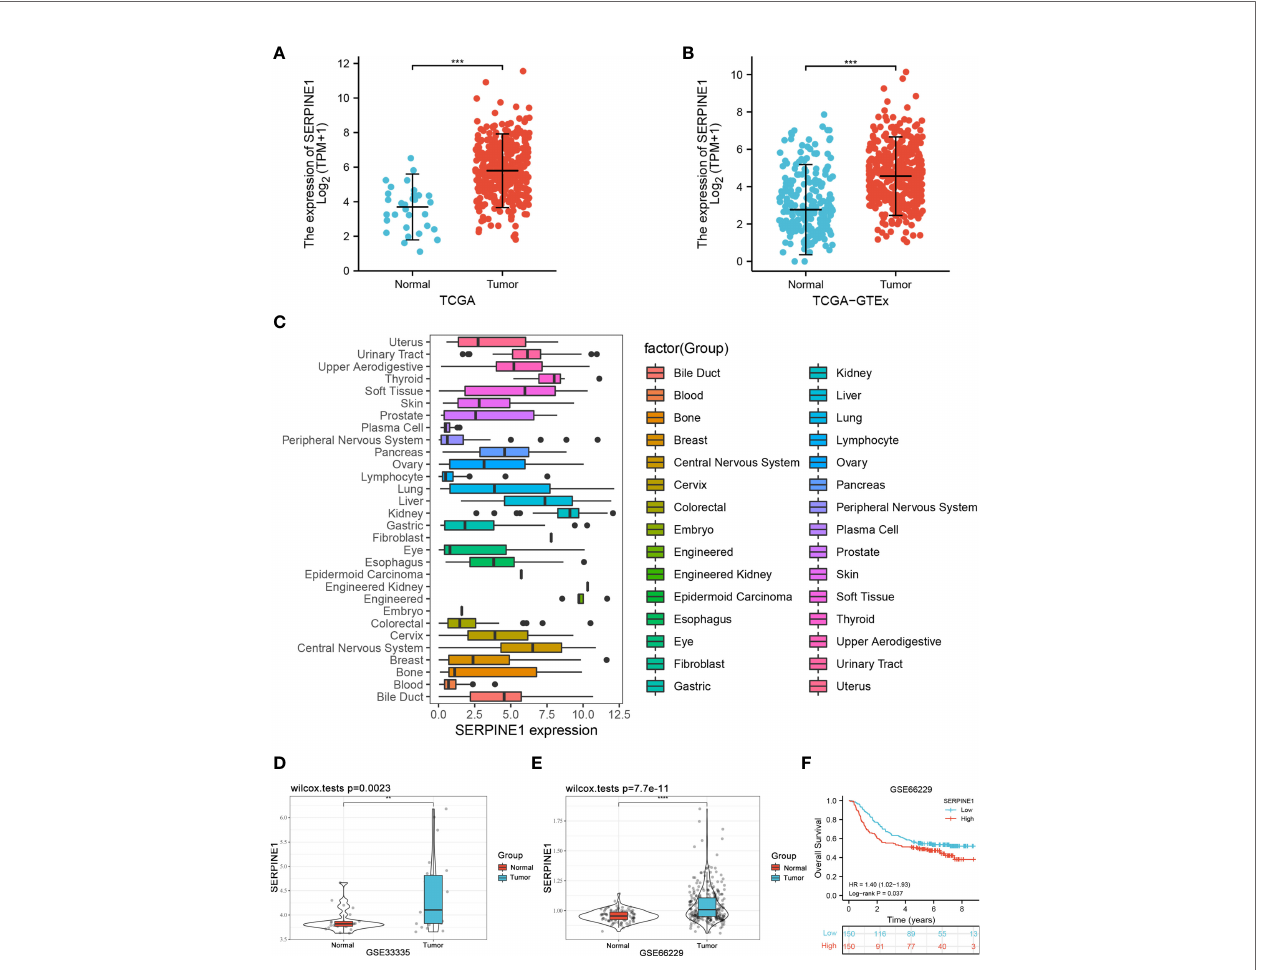
FIGURE 8 | Validation of SERPINE1 expression. (A) The expression of SERPINE1 in TCGA-STAD cohort of 32 adjacent normal samples and 375 tumor samples. (B) The expression of SERPINE1 in TCGA-STAD cohort and GTEx cohorts of 206 normal samples and 375 tumor samples. (C) Expression distribution of SERPINE1 in pan-cancer cell lines. (D) The expression of SERPINE1 in the GSE33335 STAD cohort of 25 paired STAD samples. (E) The expression of SERPINE1 in the GSE66229 STAD cohort of 100 normal samples and 300 tumor samples. (F) Survival analysis of GSE66229. **p < 0.01, ***p < 0.001, ****p <